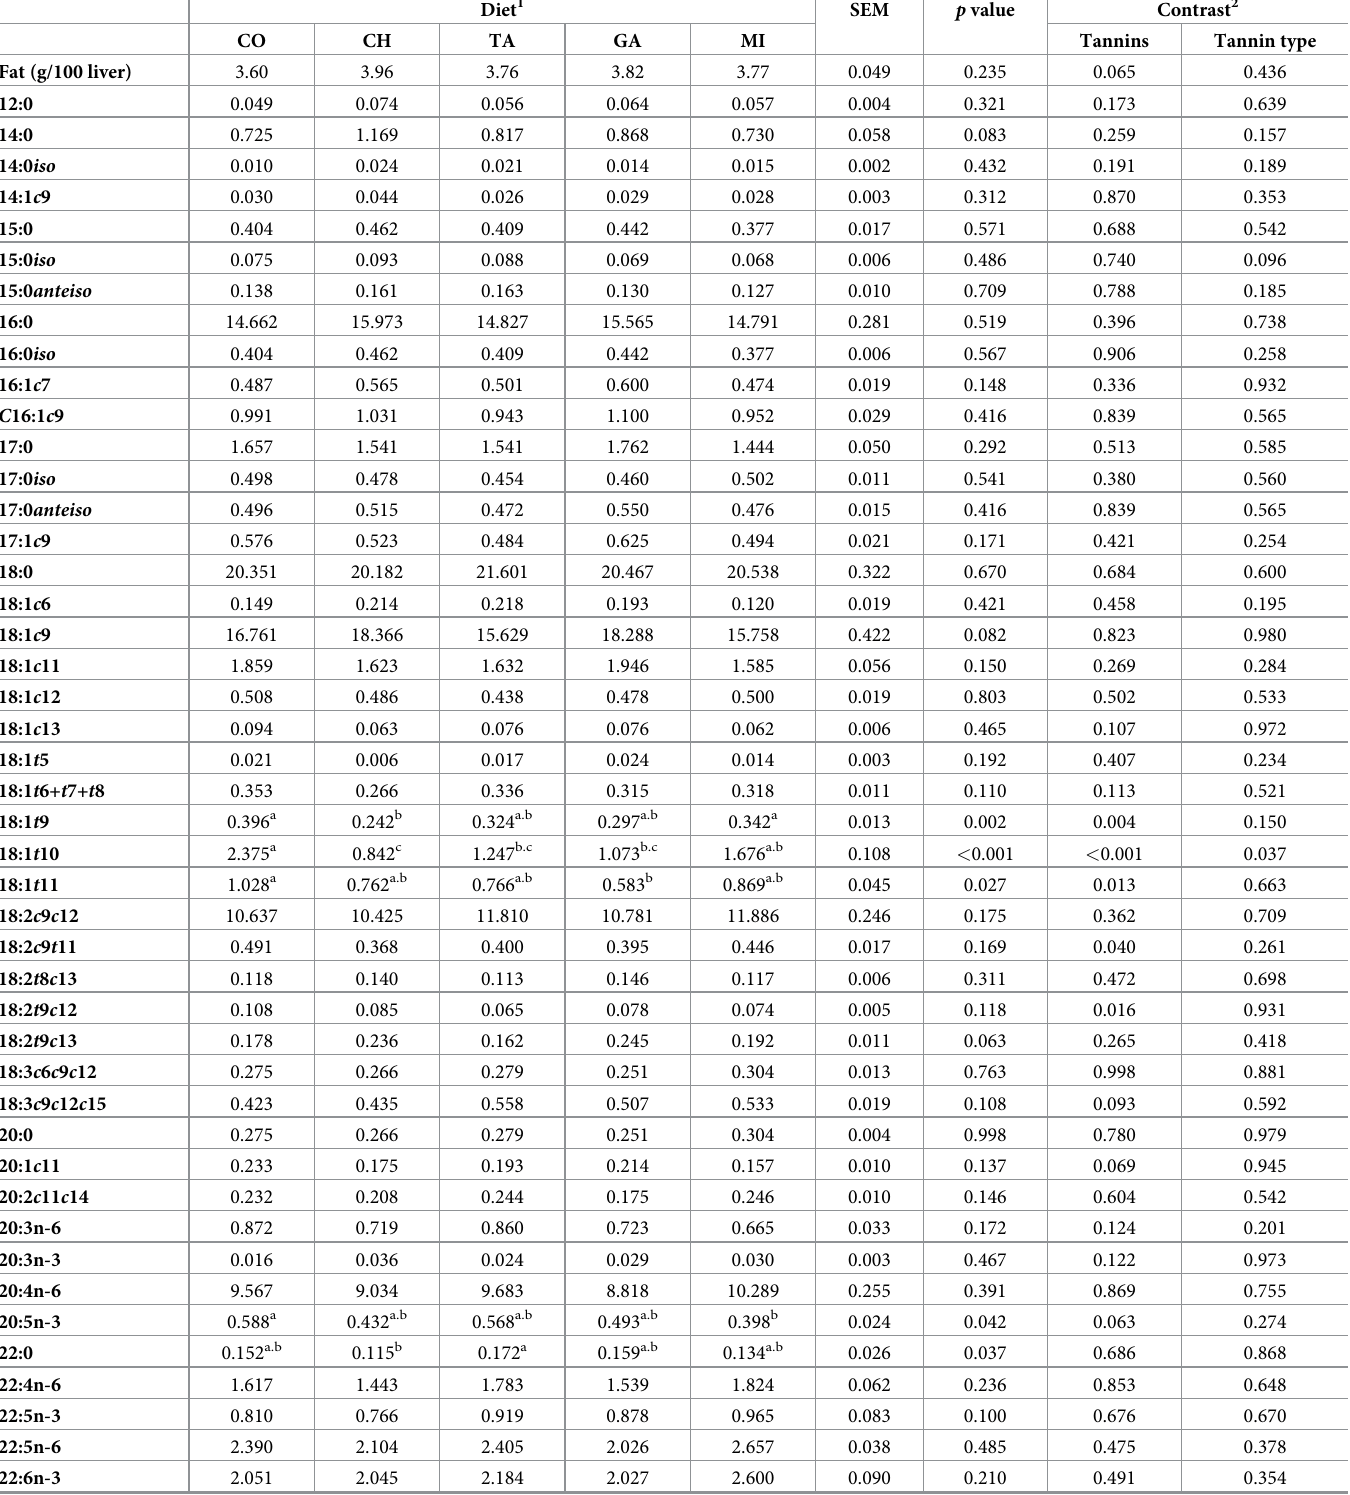
Table 4. Effect of different tannin extracts on liver fatty acid composition (g/100g total fatty acids). Diet 1 SEM p value Contrast